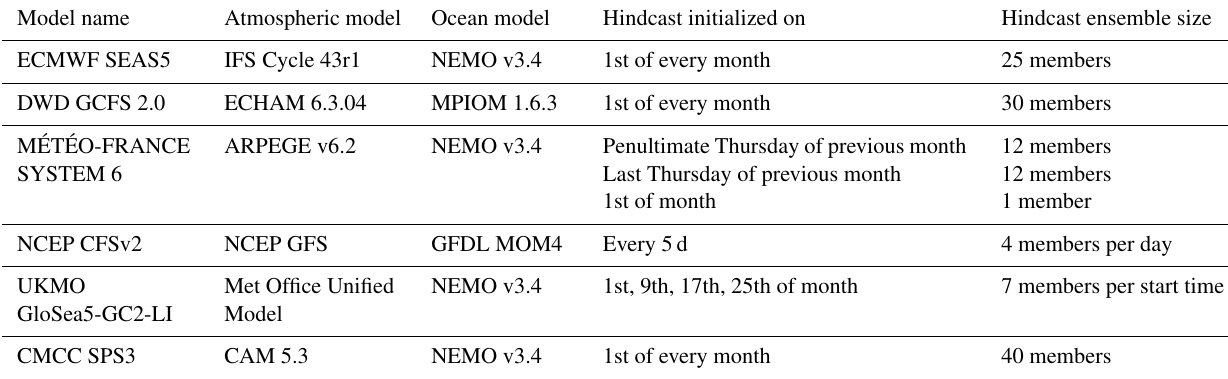
Table 1. Summary of forecast models.